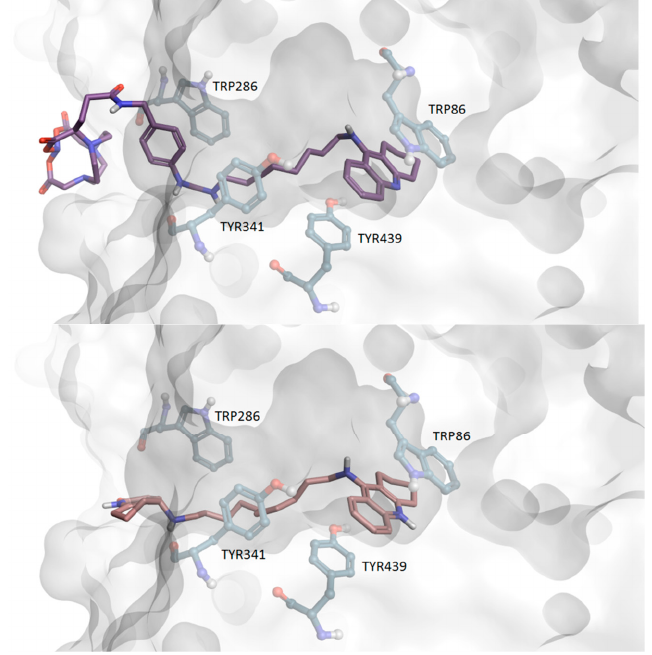
Figure 8. The side section of the hAChE’s binding pocket is docked with Ga ‐ THP ‐ NH(CH 2 ) 9 Tac ( top ), Ga ‐ NODAGA ‐ Bn ‐ NH(CH 2 ) 9 Tac ( middle ), and the template ligand ((RS) ‐ tacrine(10) ‐ hupyridone) inhibitor ( bottom ), from the superimposed PDB id: 1ZGC structure. The key aromatic AChE’s residues involved in the pi ‐ stacking interactions with ligands are in balls ‐ and ‐ sticks representation.